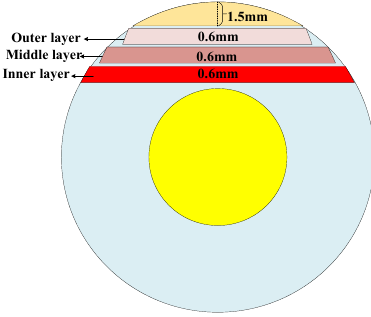
Figure 3. Schematic diagram of cable crosscutting process.